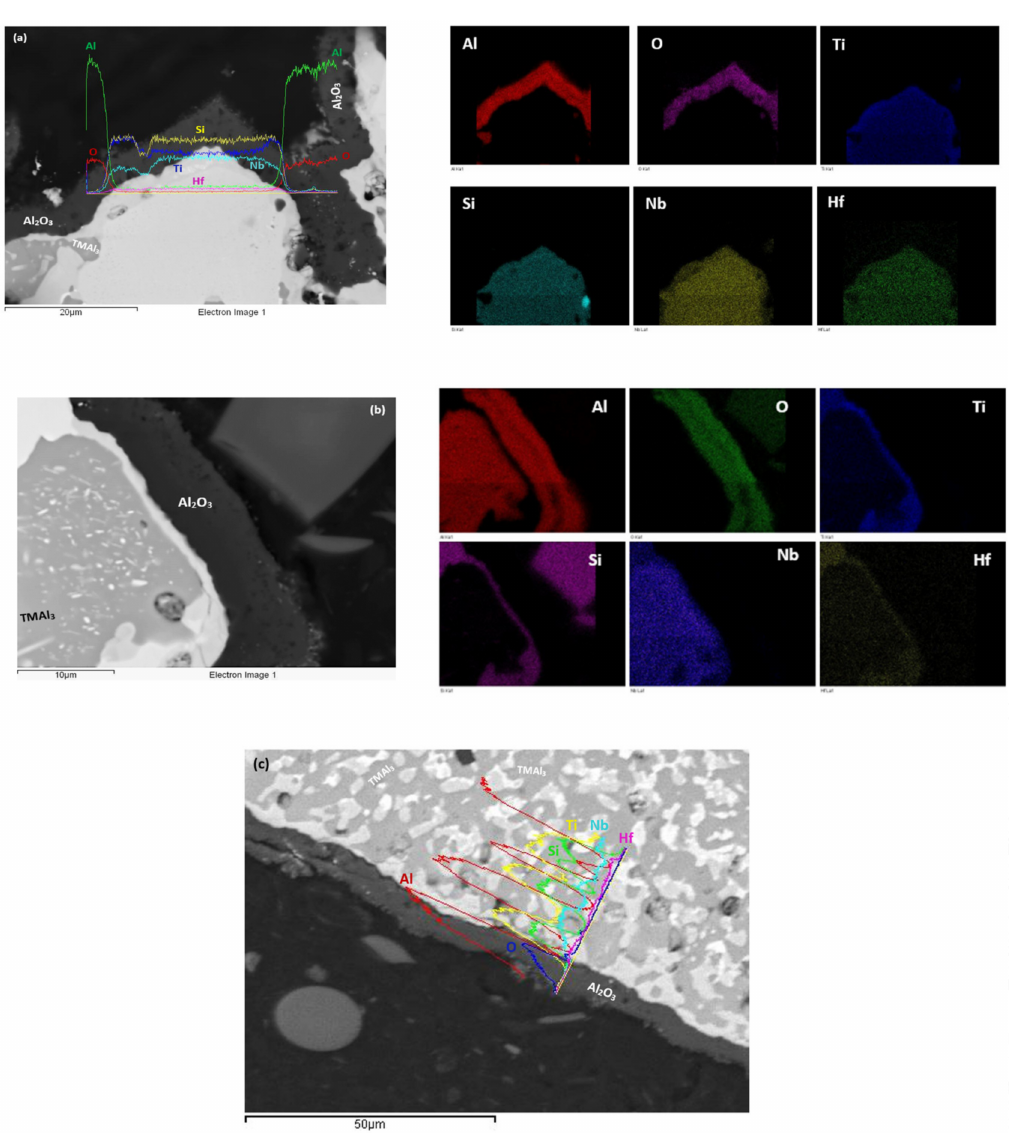
Figure 10. ( a , b ) BSE images and corresponding elemental maps of oxidised specimens at 1200 ◦ C of the alloy MG5 and ( c ) EDS line scans from scale to bulk of oxidised specimen of the alloy MG6 at 1200 ◦